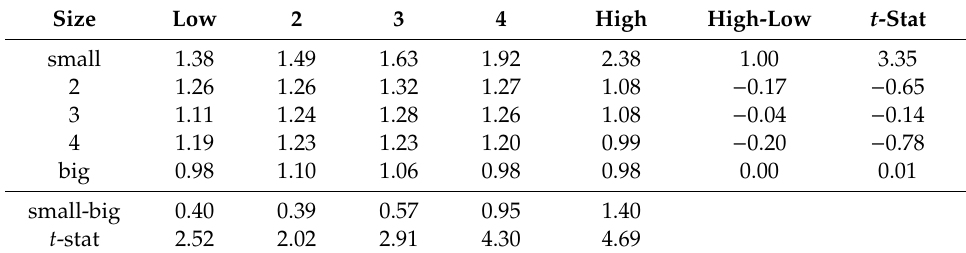
Table 9. Average returns from double-sorted quantile portfolios (sorted by size and Geske’s short-term default probability). From the data for July 1963 to December 2013, at the end of each month, stocks are independently sorted into 5 × 5 portfolios based on size and Geske’s short-term default probability. The table shows average returns for each of 25 portfolios. Small–big is the return di ff erential between the small and big firm portfolios within each default quantile. High–low is the return di ff erential between the high and low default probability firms within each size quantile. t -statistics are calculated using Newey-West standard errors.